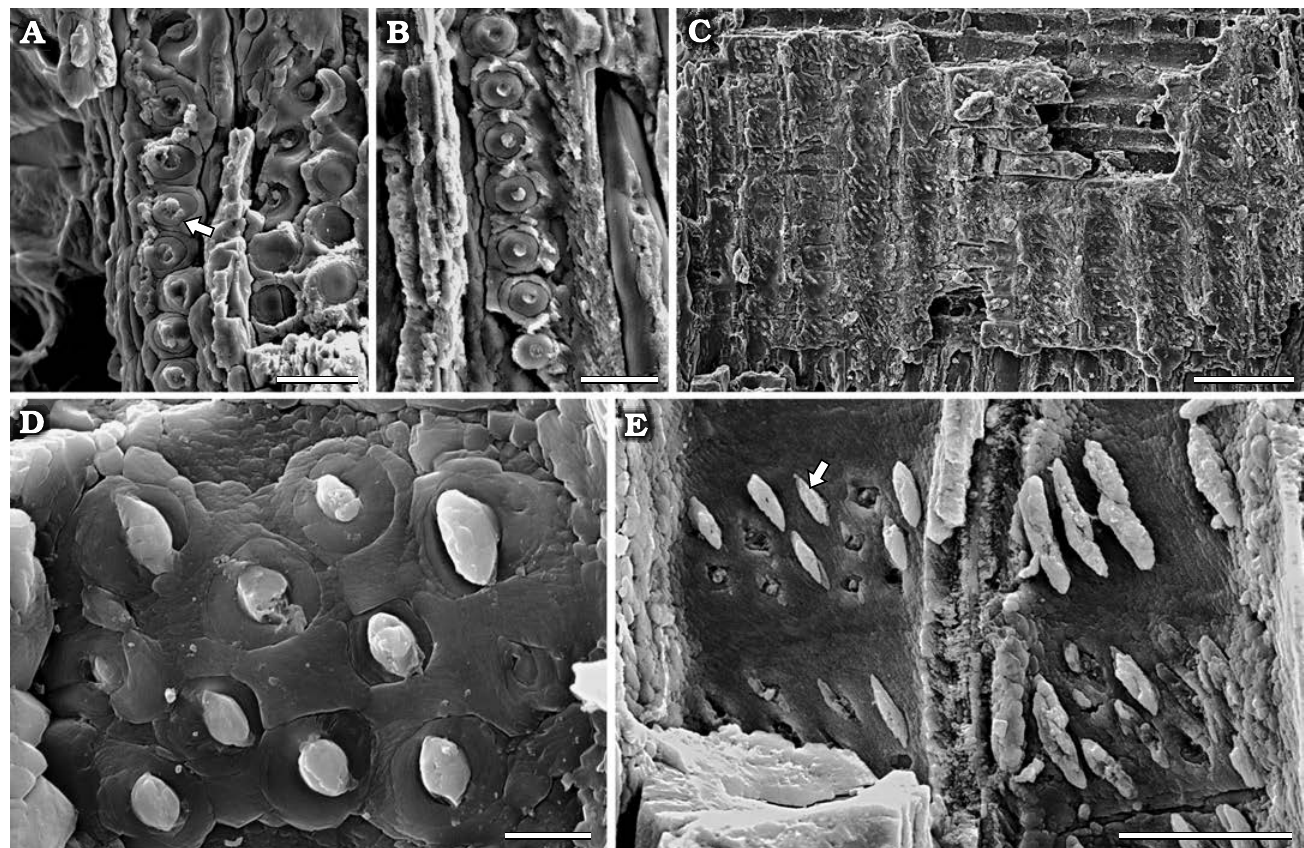
Fig. 9. Araucarian wood Agathoxylon mendezii sp. nov. (MPM­PB­15596), Estancia El Álamo, Santa Cruz Province, Argentina, Berriasian–Valanginian. Details of radial sections under SEM. A . Tracheid with slightly flattened pits (arrow). B . Tracheid showing contiguous pits with circular inner aperture. C – E . Araucarioid cross­field pits. C . General aspect. D . Contiguous alternate bordered pits placed in four vertical rows. Note circular pits in outline and circular inner aperture. E . Detail of inner apertures infilled with Si cement in elliptical form (arrow). Scale bars: A, B, E, 25 µm; C, 100 µm; D, 5